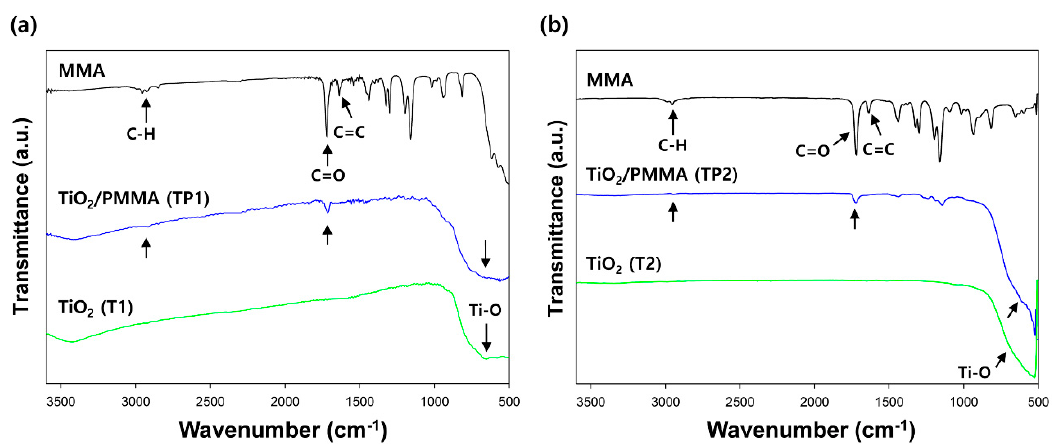
Figure 3. FT-IR spectra of the MMA monomer, the pure TiO 2 nanoparticles (( a ) and ( b )), and the TiO 2 /PMMA hybrid nanoparticles (( a ) and ( b )).